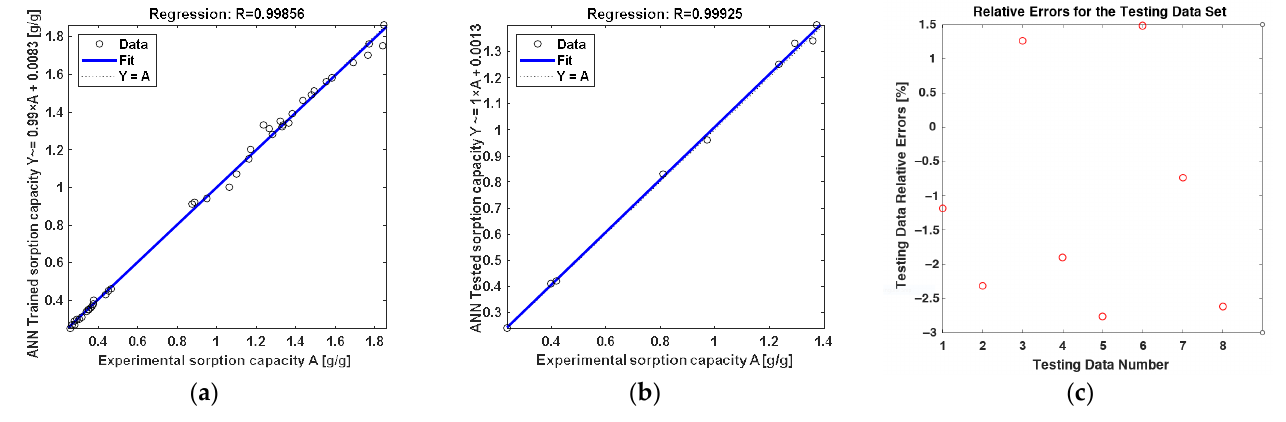
Figure 4 . Regression ( a , b ) and relative errors ( c ) between ANN simulated data and target data for the training ( a ) and testing data ( b ) subsets, case of ANN sorption model for the 10% contaminated soil .